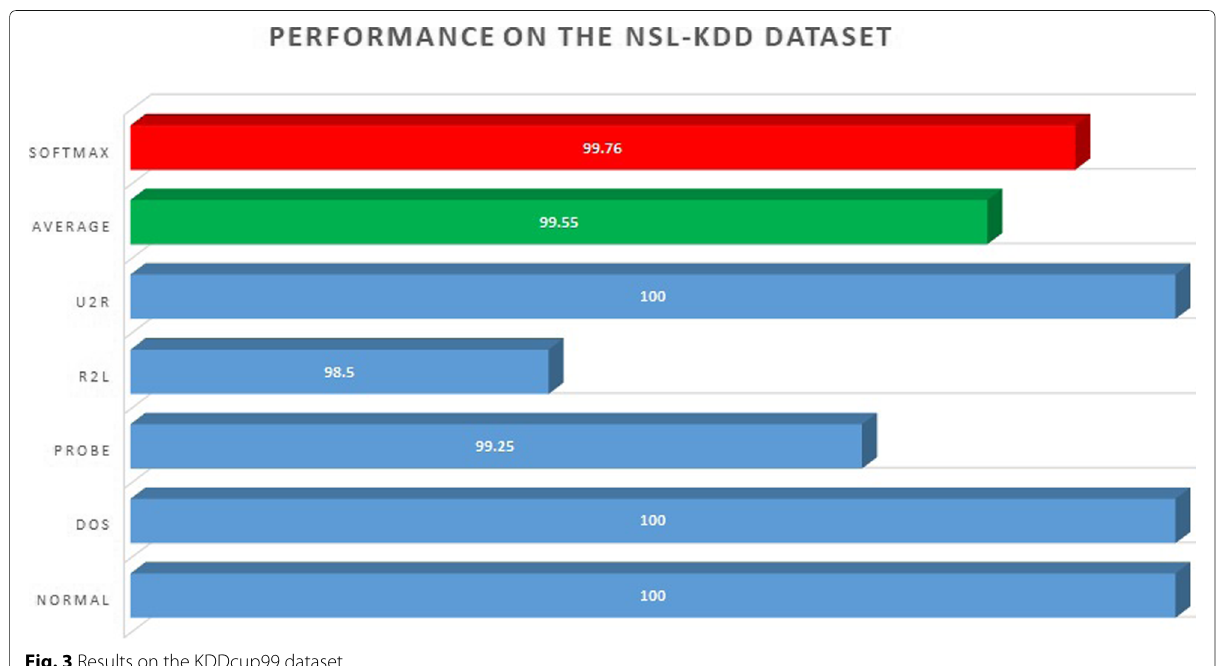
detection accuracy is already close to 100%, and since the dataset is quite large, some instances are bound to be mis- classified. Also, note that the rest of system remains the same. So, the number of features selected by the Extra- Trees classifier is the same for both the systems (with ELM or WELM).